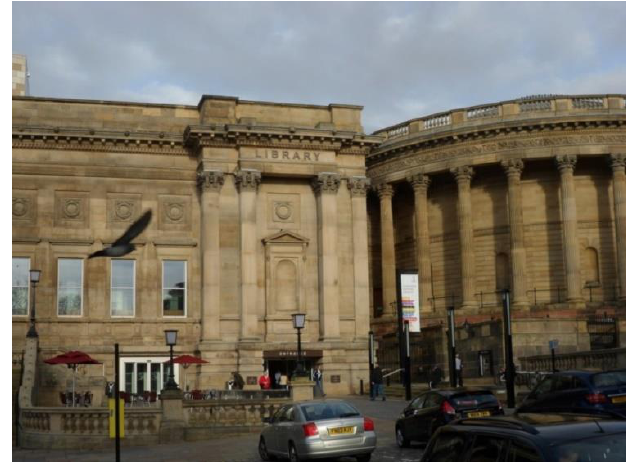
Figure 12. Example of libraries promoting respect and social inclusion (P15) (Central Library, Liverpool).